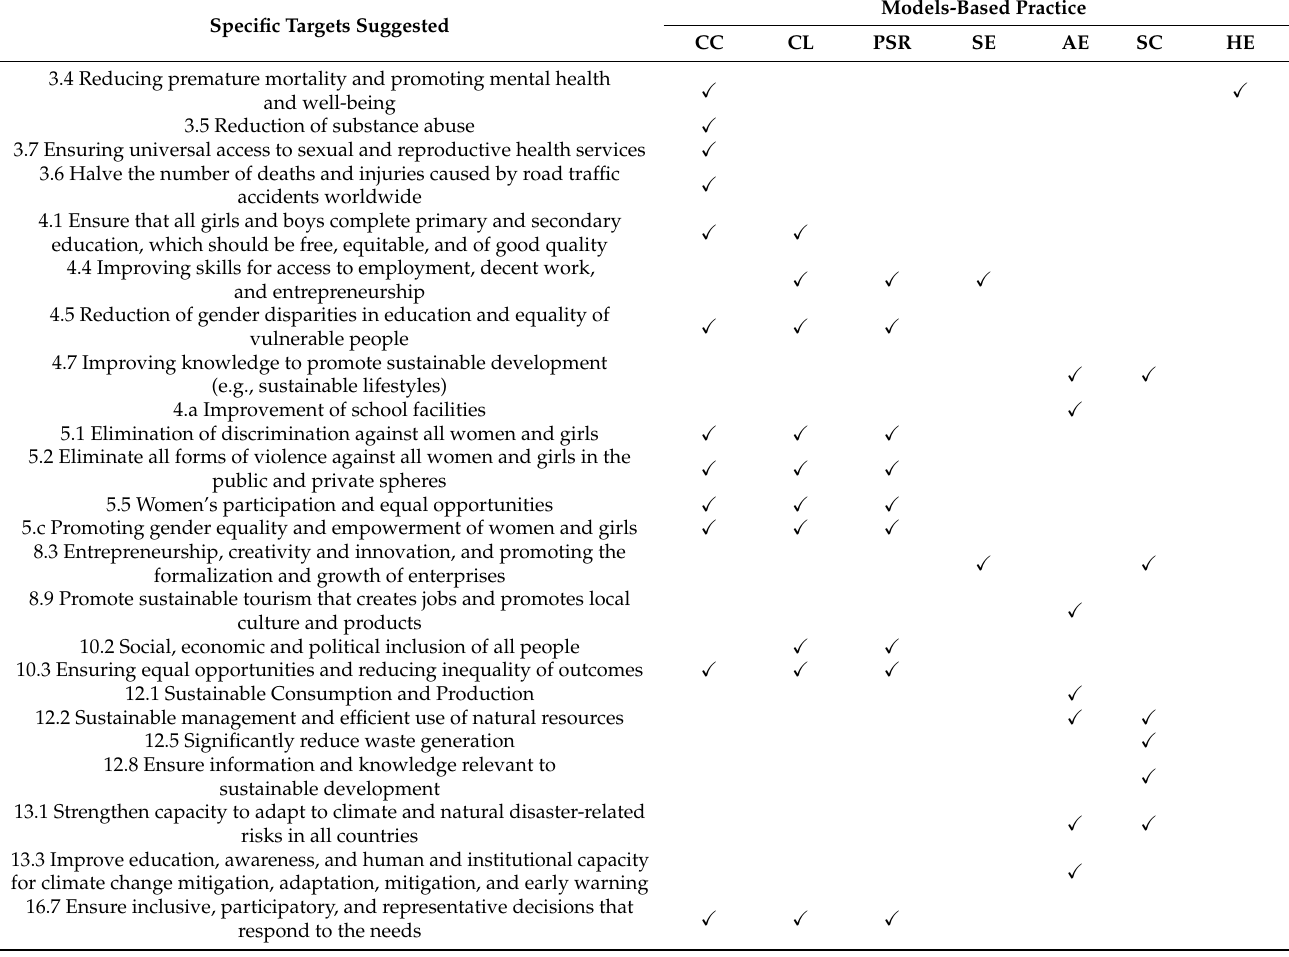
Table 2. Proposed relationship between Models-Based Practice and the specific targets of the SDGs suggested for Physical